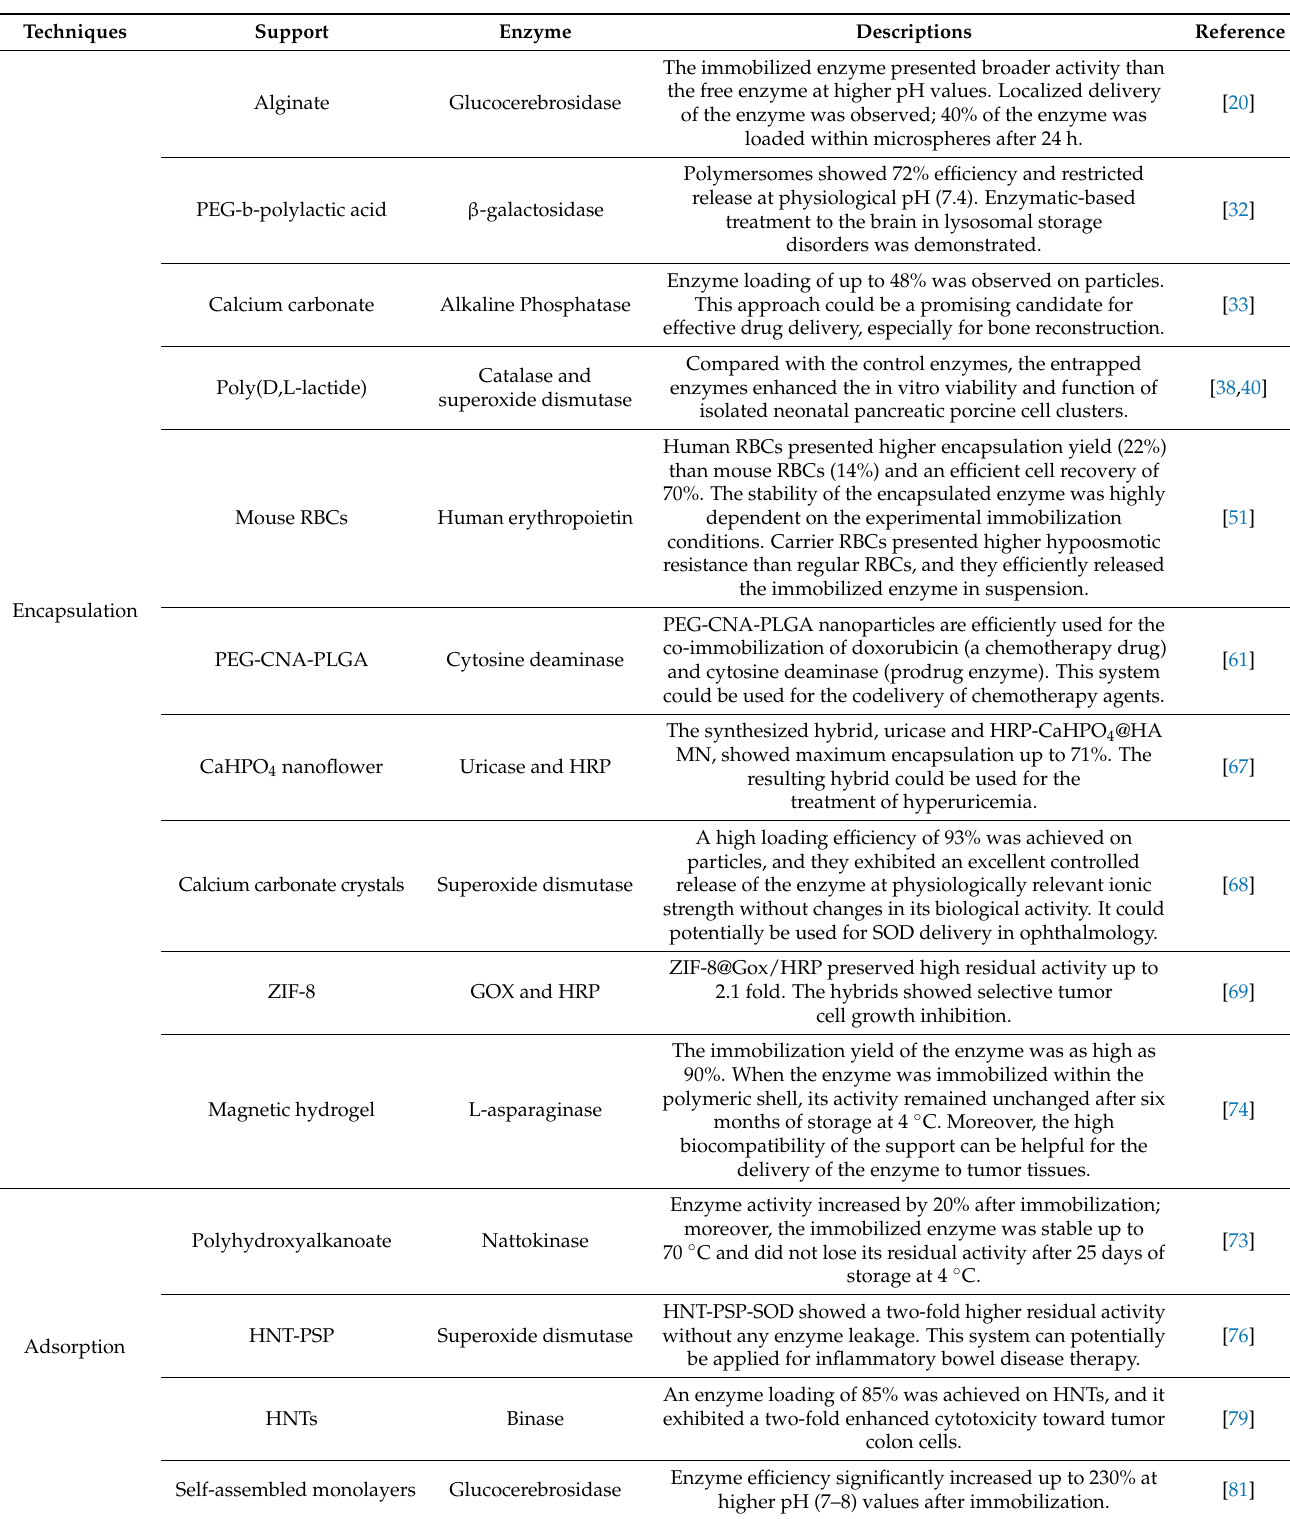
Table 1. Descriptions of various therapeutic enzymes immobilized through different